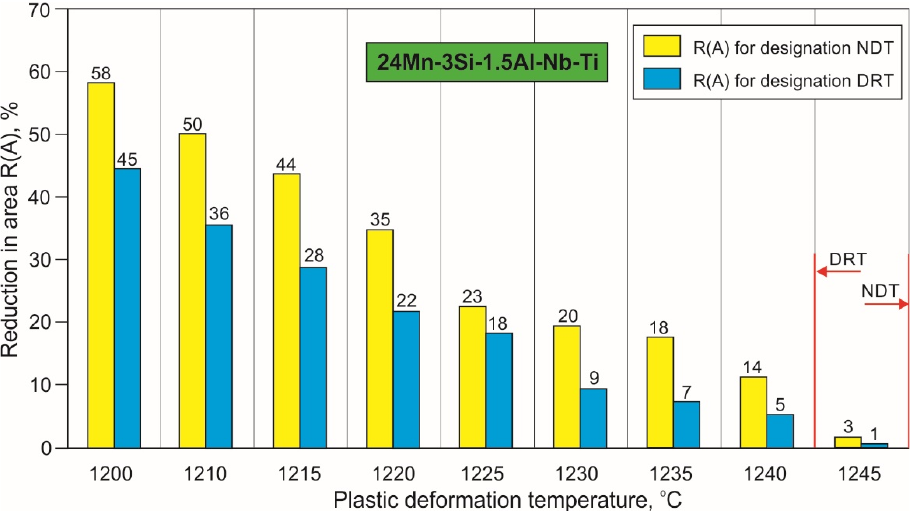
Figure 9. Influence of plastic deformation temperature on the reduction in area R(A) of samples of 24Mn-3Si-1.5Al-Nb-Ti steel after tensile force according to the scheme shown in Figures 2b and 3b. The temperature of loss of plasticity during the heating of 27Mn-4Si-2Al-Nb steel is NDT = 1235 °C, while this steel regains its plasticity during cooling at DRT = 1220 °C. The determined indices for the 24Mn-3Si-1.5Al-Nb-Ti steel are NDT = 1250 °C and DRT = 1240 °C. The designated high-temperature brittleness range of 27Mn-4Si-2Al-Nb steel is 30 °C and is within the temperature range of 1220—1250 °C. Although the HTBR of 24Mn-3Si-1.5Al-Nb-Ti steel is also 30 °C, it is moved to a higher temperature and is in the range of 1240—1270